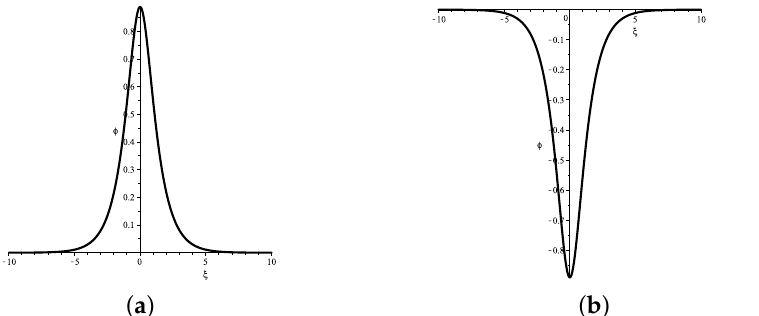
Figure 9. Solitary wave forms of system (5). ( a ) Bright solitary wave derived by (19) + . ( b ) Dark solitary wave derived by (19) −